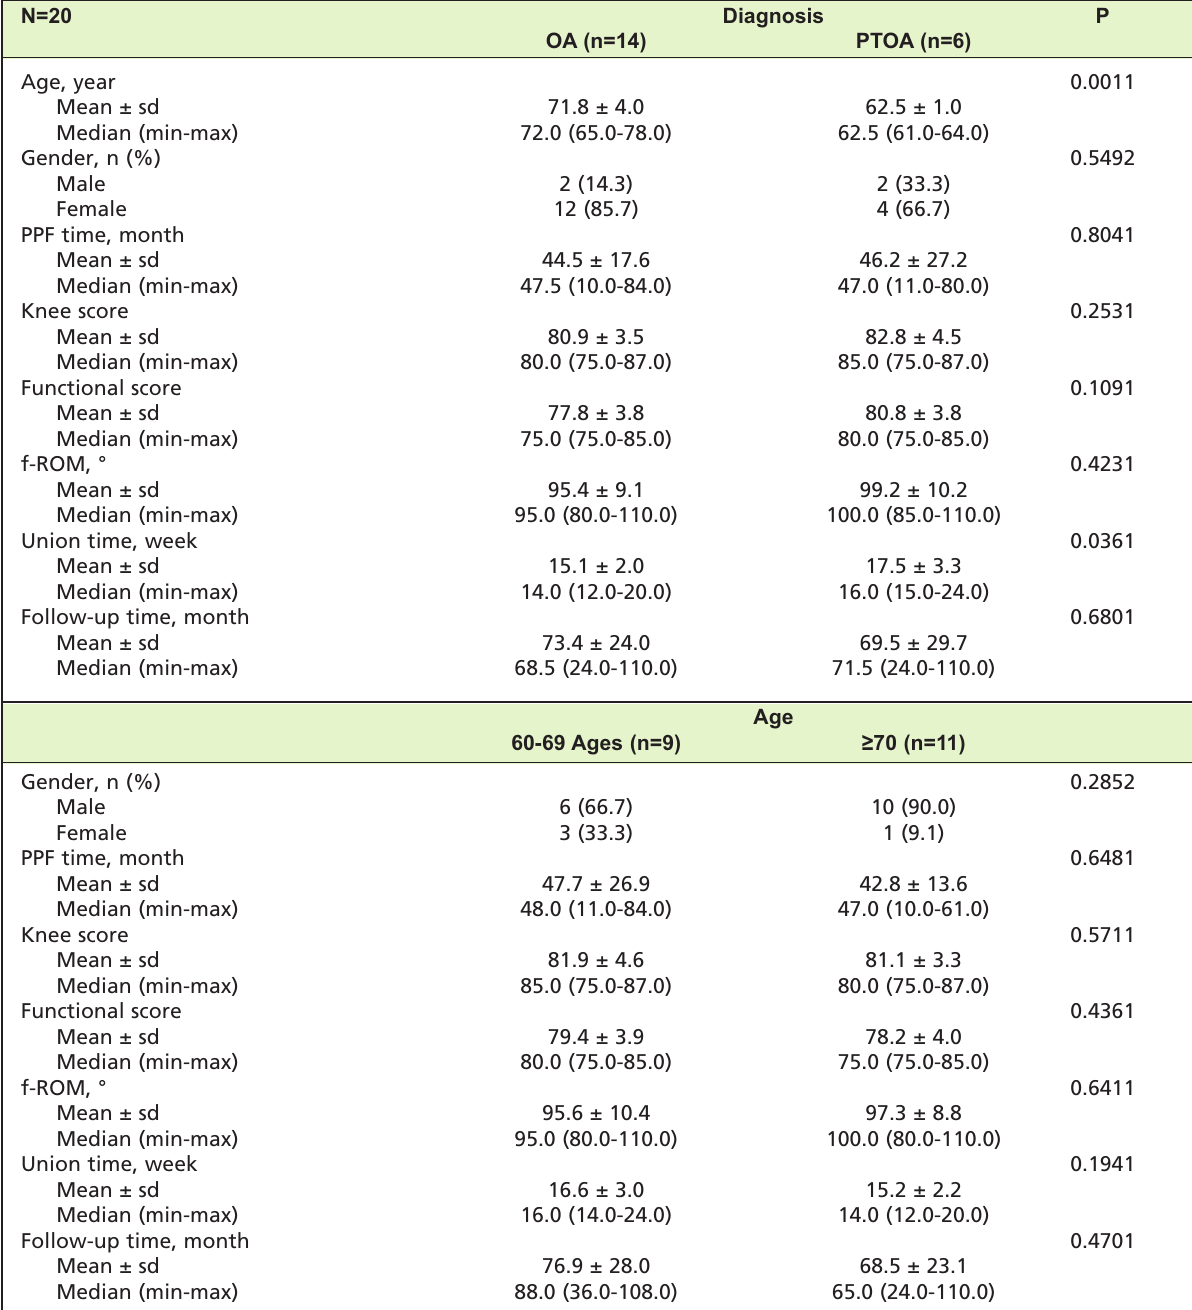
Spearman’s Correlation Coefficient between Age, Knee score, Functional score, Flexion range of motion degrees, Table II: PPF time and Union